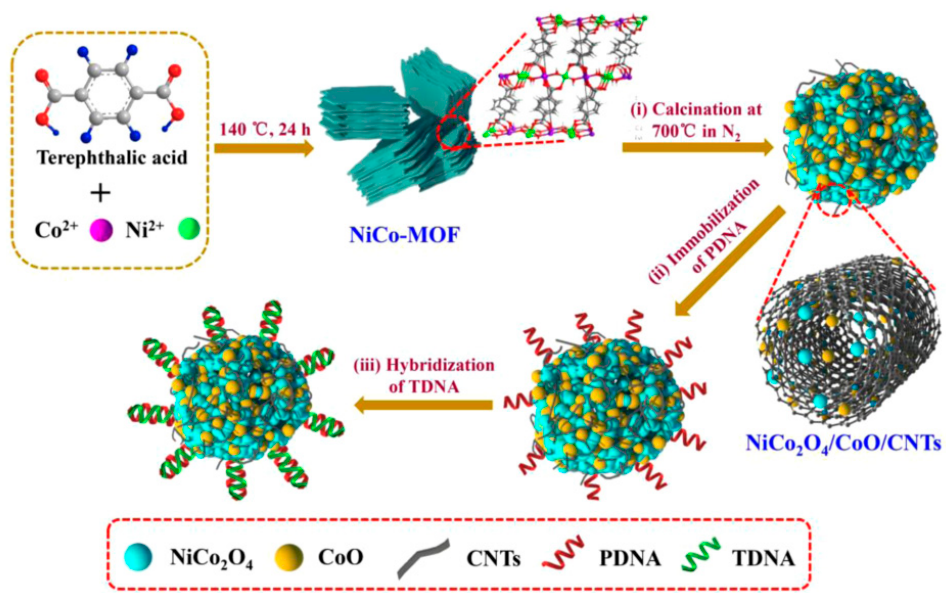
Figure 7. Schematic depiction of various steps to prepare NiCo 2 O 4 / CoO / CNTs-based assay to identify HIV-1 DNA; producing NiCo 2 O 4 / CoO / CNTs-based assay, The DNA probes immobilized, and the detection of the HIV-1 DNA [151]. It is reprinted with permission from Elsevier.